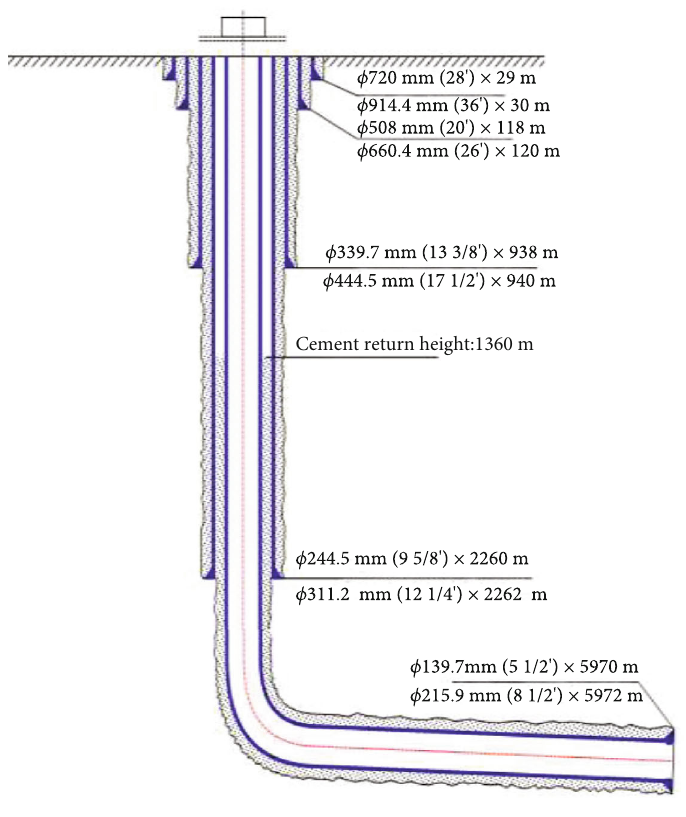
Figure 9: Chart of casing program of well